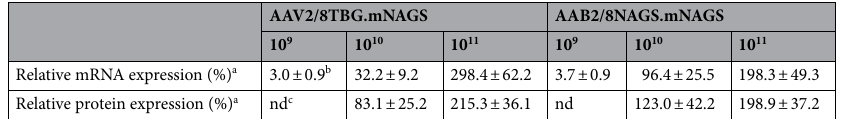
Table 1. Relative expression of Nags mRNA and NAGS protein in Nags −/− mice injected with increasing doses of AAV2/8TBG.mNAGS and AAV2/8NAGS.mNAGS viral vectors. a Abundance of Nags mRNA and protein in